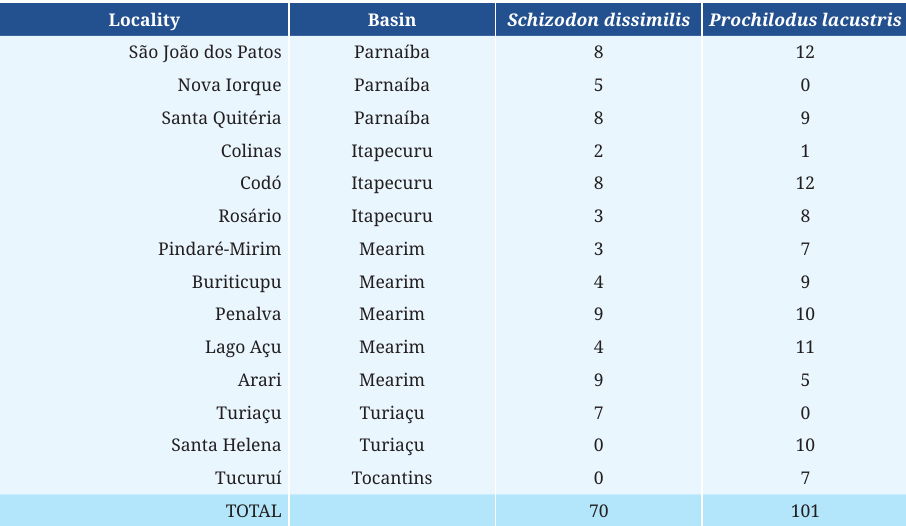
TABLE 1 | Sampling sites of Schizodon dissimilis and Prochilodus lacustris analyzed in this study. Numbers in species columns indicate number of sampled